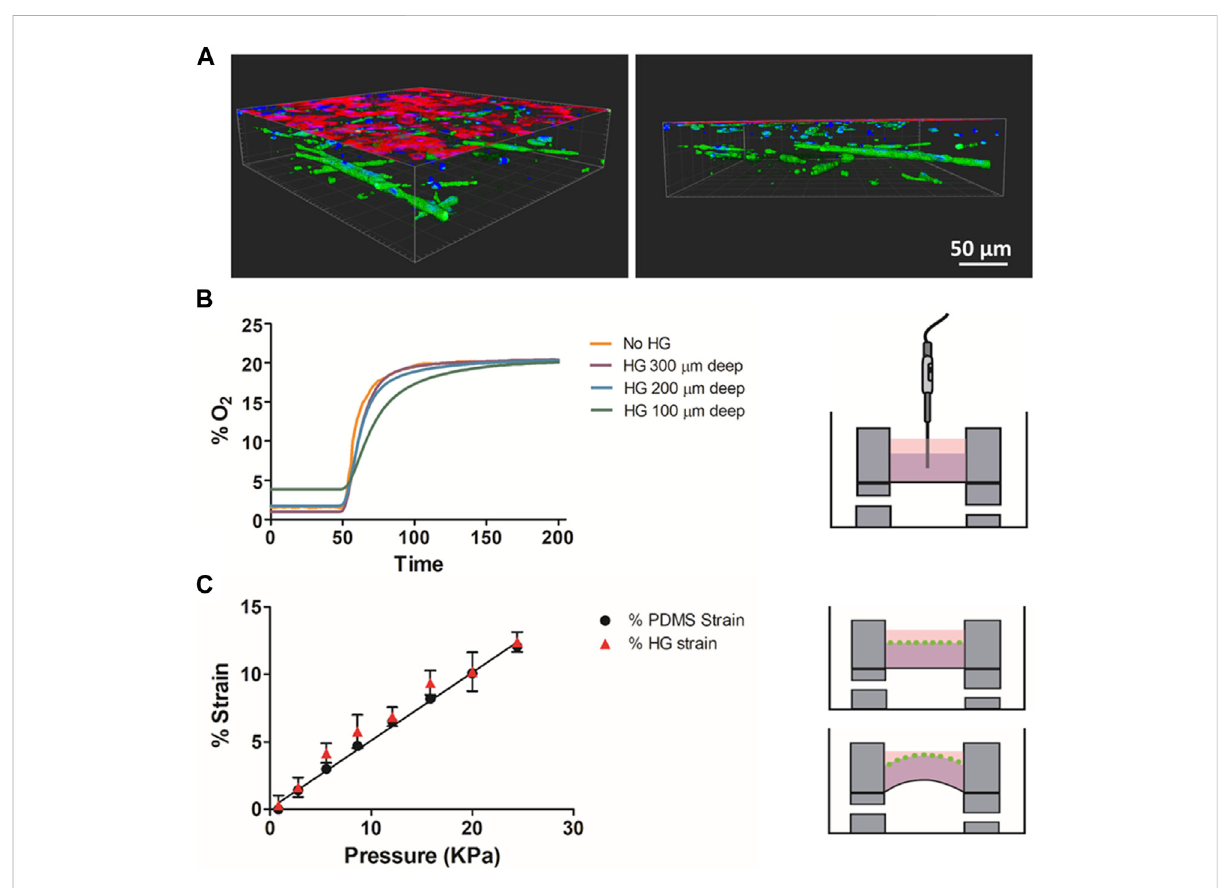
FIGURE 4 (A) Confocal images of the alveolar monolayer on top of the ECM hydrogels with LMSCs cultured inside. Alveolar cells (red) are stained for EpCAMandMSCs(green)arestainedforvimentin (B) Oxygendiffusionmeasurementsatdifferentdepthsofthehydrogelandliquidmedium(NoHG). (C) Measured deformation of the membrane and the attached hydrogel at different